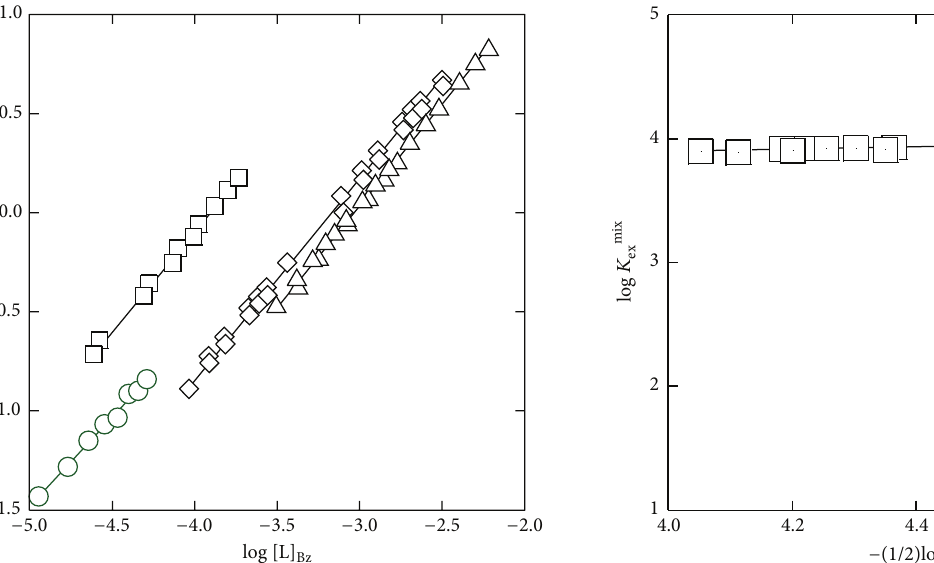
−1.5−1.0−0.50.00.51.0 Figure 1: Plots of log ( D /[ Pic − ]) versus log [ L ] for the 15C5 Figure 3: Plot of log 𝐾 exmix versus −(1/2) log 𝑃 for the NaPic Bz (square), B15C5 (diamond), 18C6 (circle), and B18C6 (triangle) extraction with L = 15C5. The 𝐾 extraction systems. See the text for regression results of the solid to be ( 7.3 ± 3.8 ) × 10 −4 M −1 and 7747 ± 149 M −2 from the nonlinear lines. The symbol of 1 moldm −3 = 1M was used. regression analysis with ) for the NaPic Figure 2: Plot of log 𝐾 exmix versus − log ([ Na + ][ L ] Bz and 𝐾 values obtained from extraction with L = 15C5. The 𝐾 D , Pic ex a nonlinear regression analysis with (1) were (7.7 ± 4.8) × 10 −5 and 8115 ± 133 M −2 , respectively. plot of log 𝐾 exmix versus −(1/2) log 𝑃 (Figure 3) based on the equation